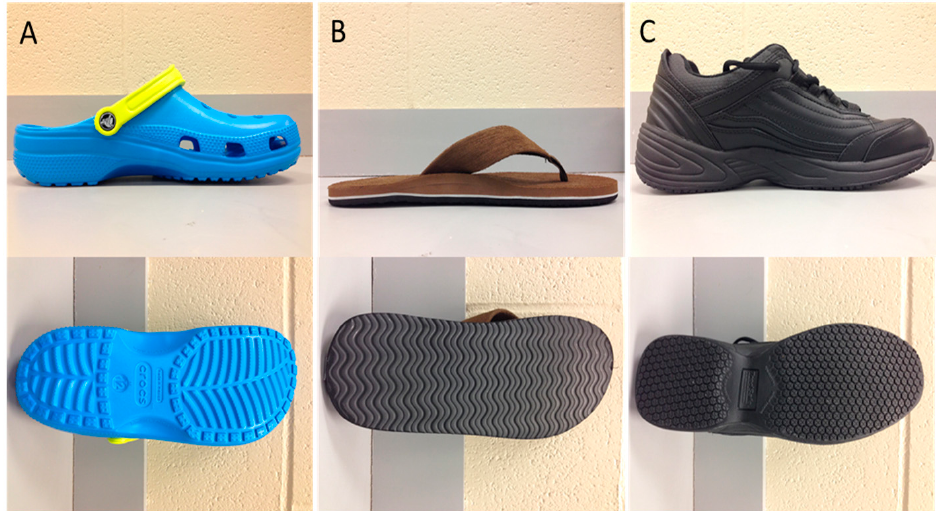
Figure 1. Alternative footwear. ( A ) Crocs with clogs (CC); ( B ) flip-flops (FF) and ( C ) low top slip resistant shoe (LT) exhibiting their overall design and sloe-tread